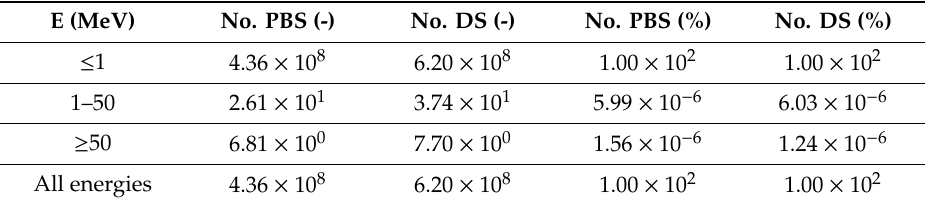
Table 2. Summarized neutron production at Position 1 and their categorization according to the ICRP 103 report [22].